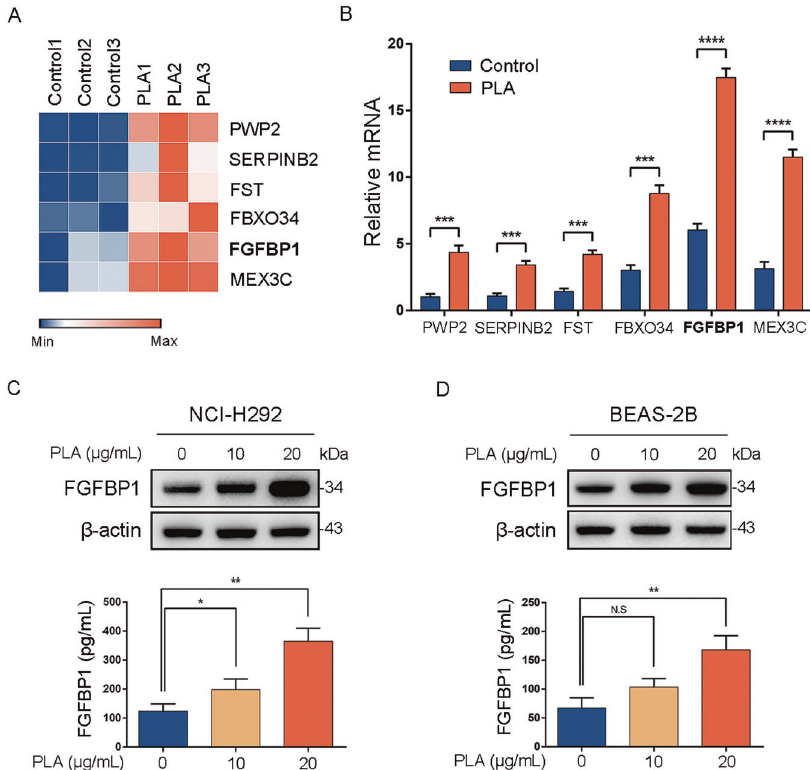
Fig. 1 PLA elevates the expression of FGFBP1 in airway epithelial cells. A Heatmap showing the top six differentially expressed genes in PLA-treated (PLA) or untreated (Control) NCI-H292 cells based on RNA-sequencing results. B NCI-H292 cells were treated with or without PLA (20 μ g/mL, 24 h) and examined for the expression of PWP2 , SREPINB2 , FST , FBXO34 , FGFBP1 , and MEX3C (normalized to GAPDH) by qRT-PCR. C , D Human airway epithelium cell lines, NCI-H292 and BEAS-2B, were treated with PLA (0, 10, and 20 μ g/mL) for 24 h. Cell lysates were subjected to immunoblotting (upper panels) and FGFBP1 levels in the cell supernatants were detected using ELISA (lower panels). Results are shown as mean ± SD from three independent experiments. * P < 0.05; ** P < 0.01; *** P < 0.001; **** P < 0.0001; NS not signi fi